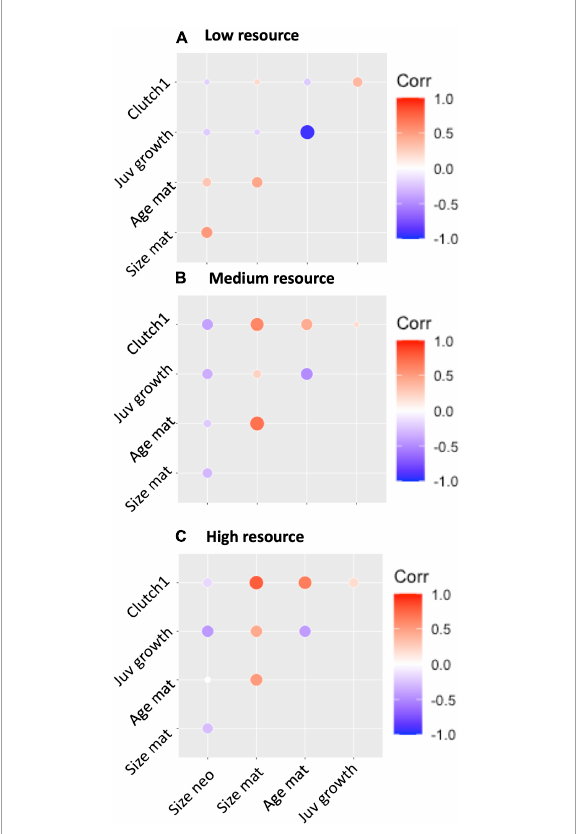
FIGURE3 Correlation matrices demonstrating the direction and strength of phenotypic correlations between all traits in (A) Low resource environments (10,000 cells Chlorella vulgaris mL − 1 ), (B) Medium resource environments (145,000 cells C. vulgaris mL − 1 ) and (C) High resource environments (300,000 cells C. vulgaris mL − 1